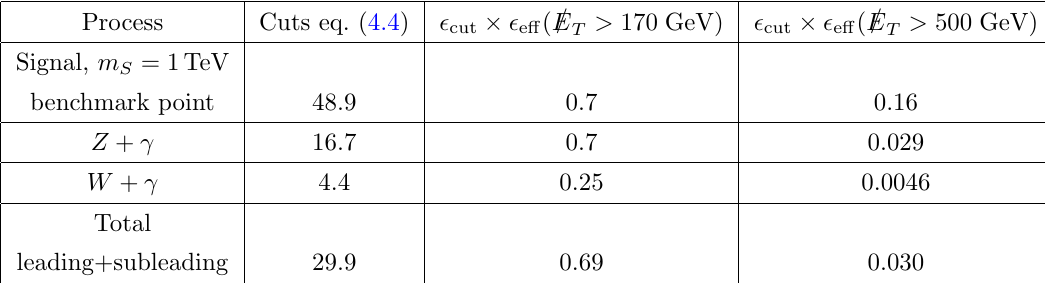
Table 1 . The cross sections after cuts of eq. (4.4), in fb, for the benchmark signal, the leading backgrounds Z + (cid:13) and W + (cid:13) , and the total backgrounds including the estimate of subleading contributions. In the rightmost columns we show the overall cut e(cid:14)ciencies for =E =E > 500 GeV and the other cuts of eq. (4.4) held (cid:12)xed. K-factors were applied (see T